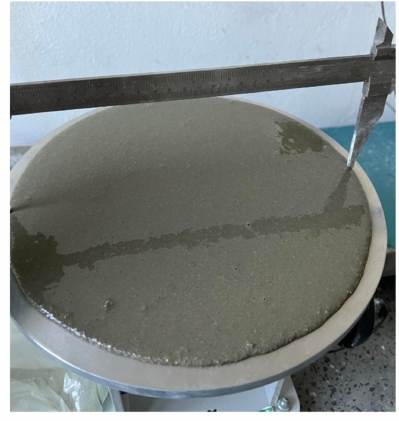
Figure 10. Consistency